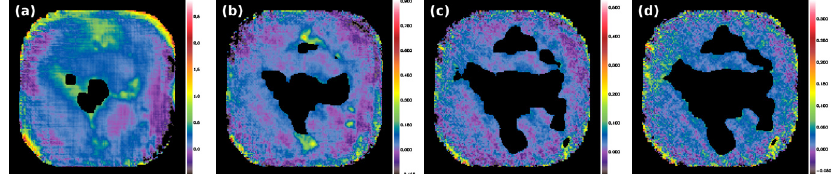
Figure 2. Source mask automatically built during baseline subtraction at various steps: (a) after first baseline subtraction ; (b) after correction for the average drift on small timescales ; (c) after correction for the drifts on the 3 . 11s timescale ; (d) after correction for the drifts on the 1 . 04s timescale. unique, there is a spurious excess drift, of the same periodicity as the geometry of the obser- vations, that is removed by another instance of the baseline subtraction, optionally including piecewise baselines for very large fields (but the same function for each leg of a scan). (3) Average drift per electronic box or sub-box, on successively smaller timescales: This component is subtracted after computing the individual drifts (as in step 4), and then their weighted average for each box or sub-box separately. (4) Individual drifts, on successively smaller timescales: Within each coarse pixel, they are computed as the di ff erence between each detector crossing and the weighted average of all